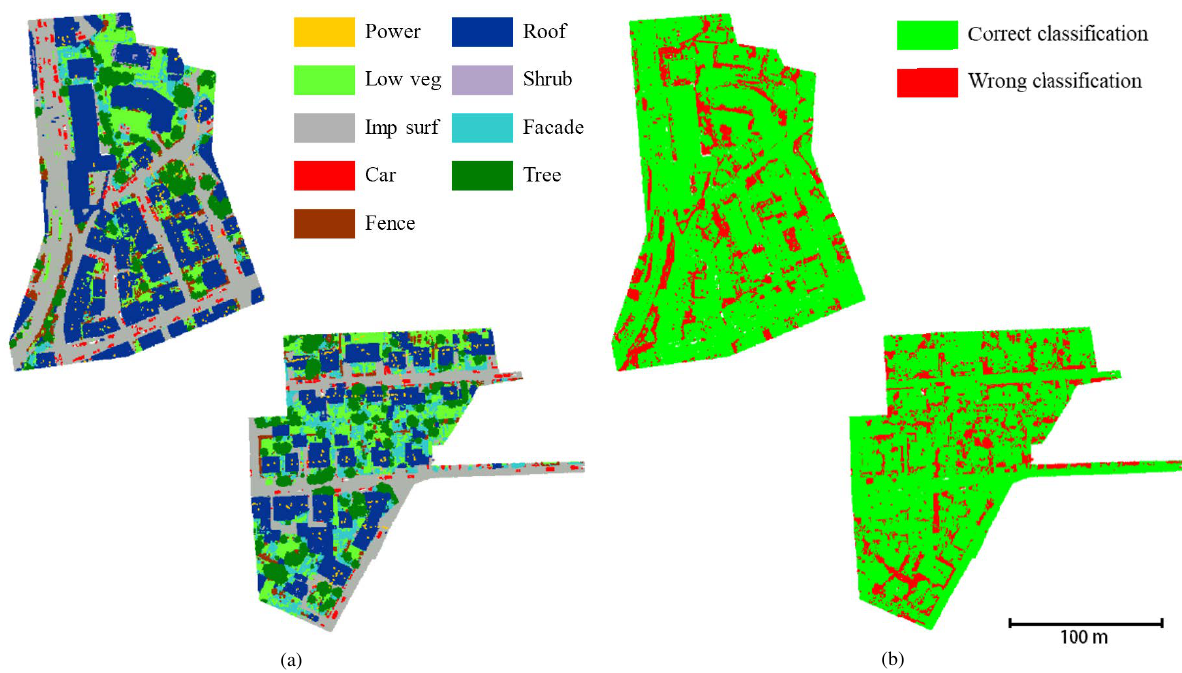
Figure 5. (a) and (b) represent the classification result and the error map of the proposed method in 100 weak-label setting, respectively. full supervision by using approximately 0.2 % of full labels in the training set only. The classification result and error map using 100 weak-label settings are shown in Fig. 5.